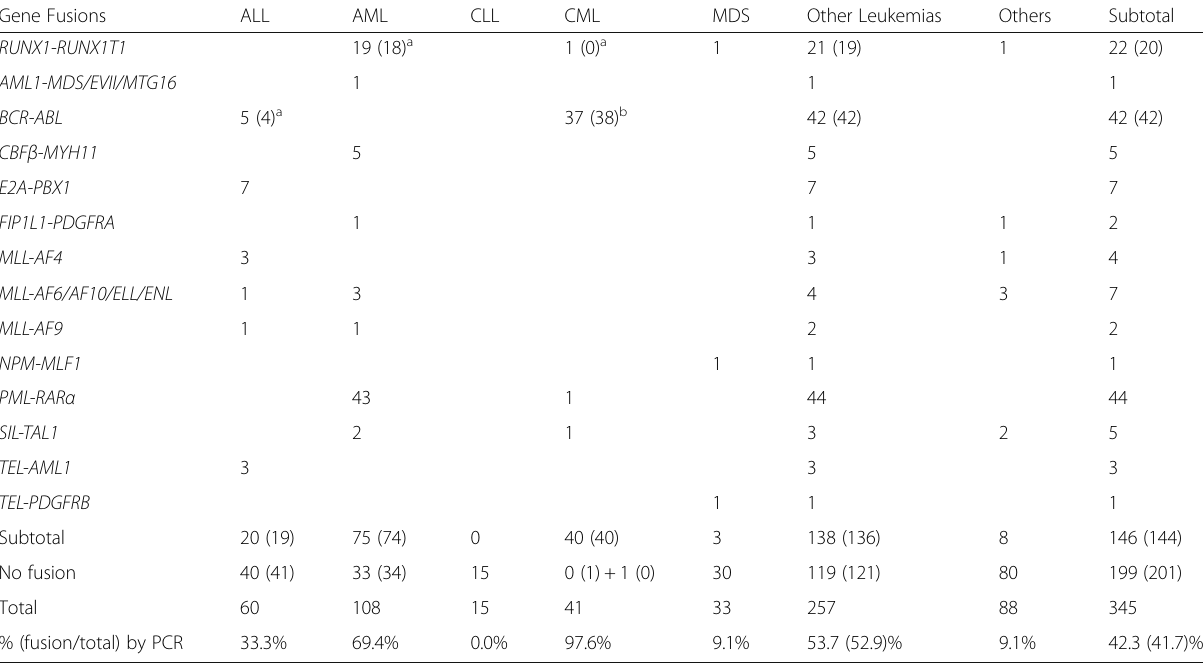
Table 6 Cases with fusion genes detected by FQ- RT-PCR in 34 leukemia patients Gene